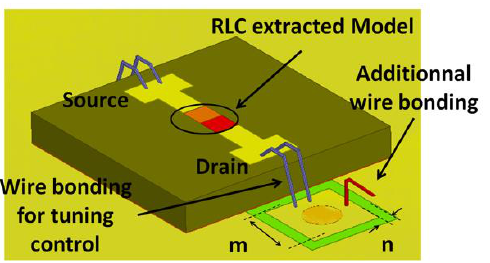
Figure 5. 3D model of an RMSW201 Radant MEMS switch.